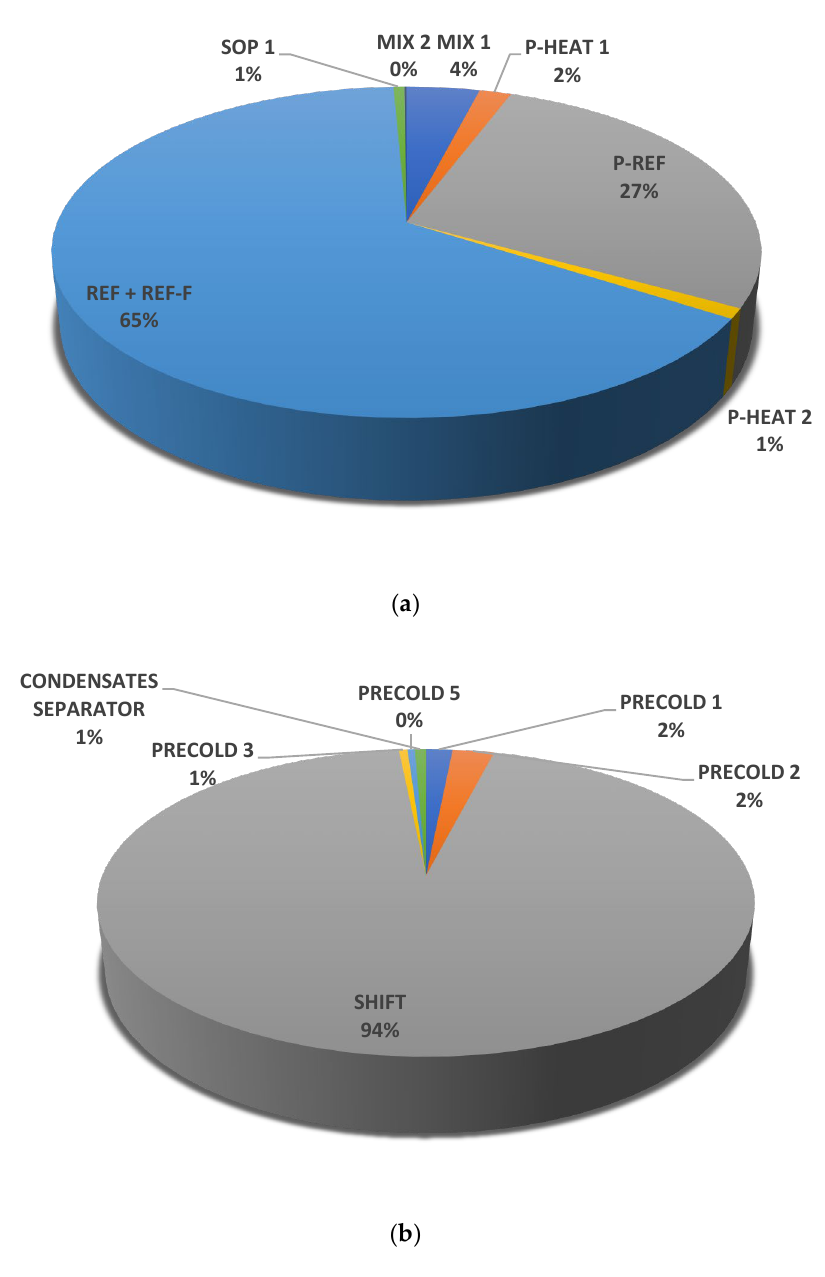
Figure 4. ( a ) Breakdown of unused exergy in Section 1; ( b ) breakdown of unused exergy in Section 2. ◦ The optimum values for S / C ratio and T cc were found to be 1.9 and 905 C, respectively. In Table 6, the results obtained from the simulation are shown for each variable studied. Table 6. Selected conditions after sensitivity